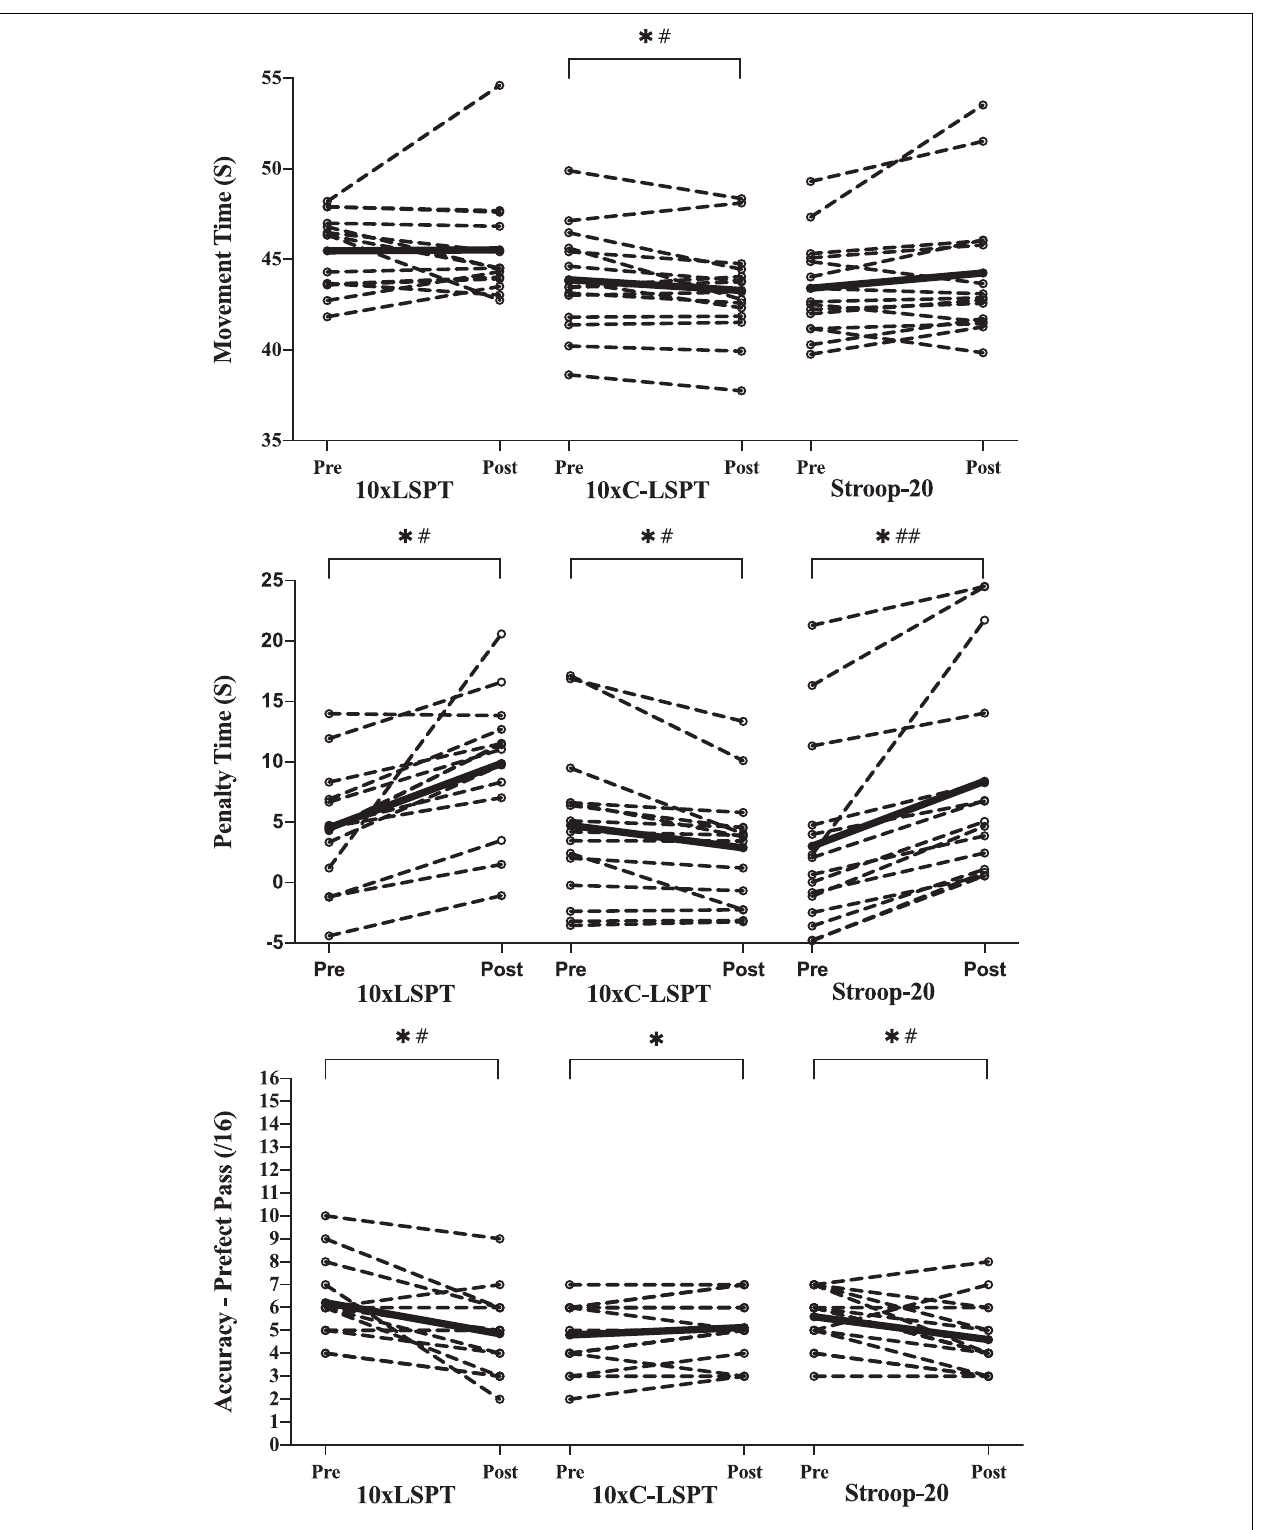
FIGURE 6 | Assessment of soccer skill performance. Circles and dashed lines indicate the data of individual participants, and black solid lines indicate the mean value. *Significant changes when compared with pretest ( p < 0.05); # moderate effect; ## strong effect; the response time data of one player were excluded ( > 1.5 s); 10xLSPT, repeated interval Loughborough Soccer Passing Test; 10xC-LSPT, repeated interval modified Loughborough Soccer Passing Test in clockwise order of pass direction; Stroop-20, 20-min Stroop task.